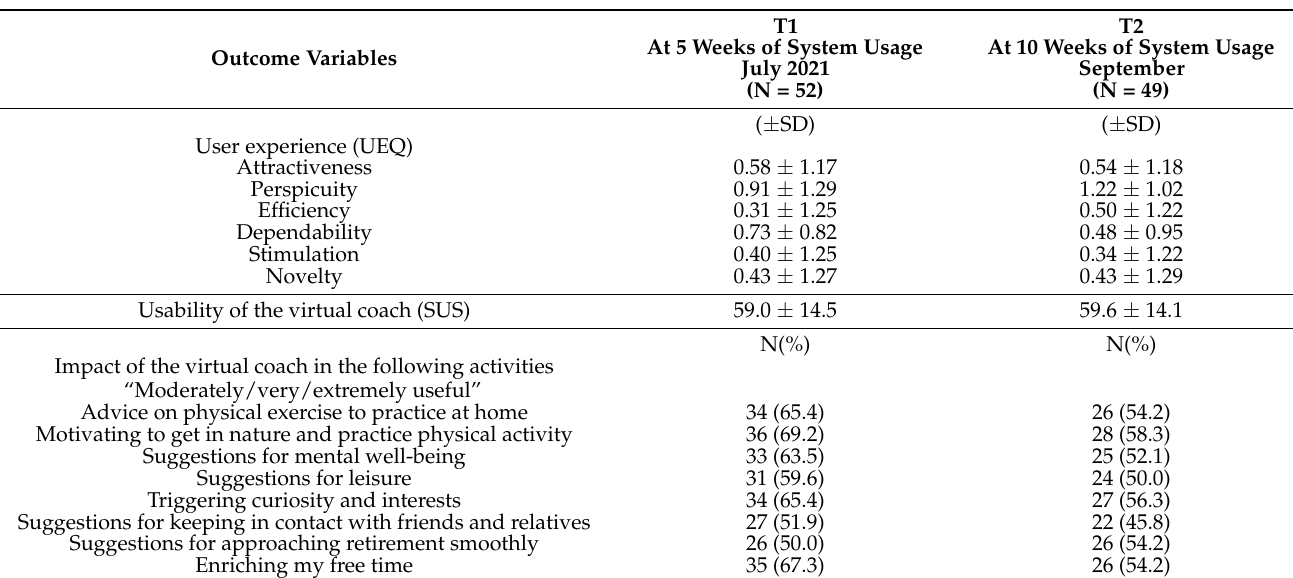
Table 4. User experience and system usability.